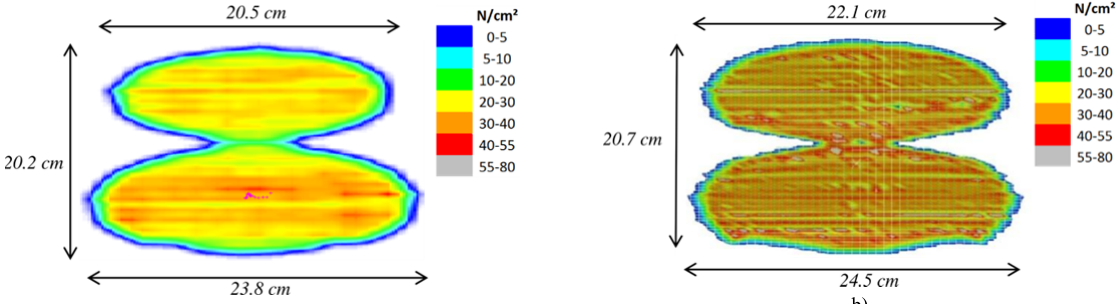
Fig. 10 Comparison of tyre footprints for a drop height of 700 mm at t = 24.0 ms after impact at a drop height of 700 mm: a) Experimental measurement and b) Simulated